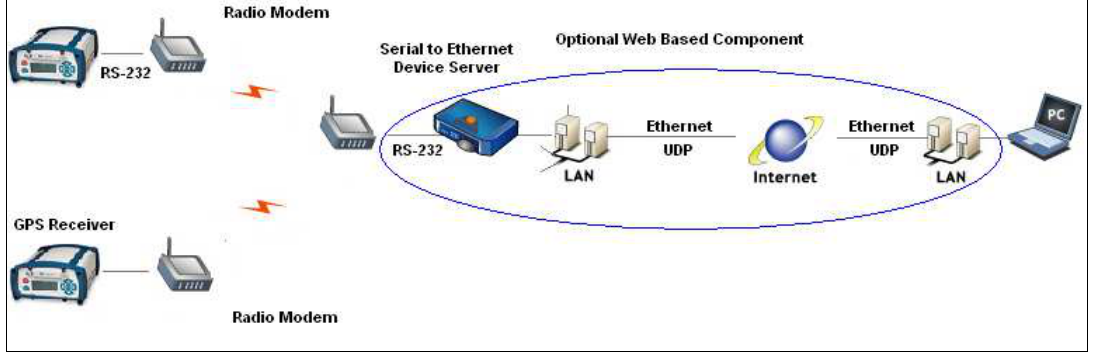
Figure 7. Radio Modem based